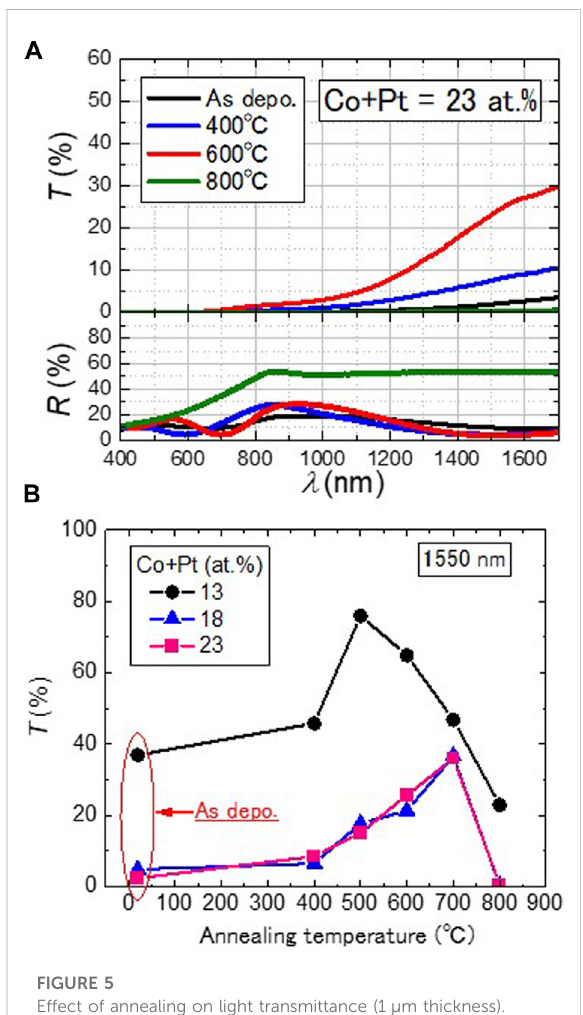
FIGURE 5 Effect of annealing on light transmittance (1 μ m thickness). (A) Wavelength dependence of the transmittance of (Co-Pt)- (CaF 2 ) (Co. + Pt = 13, 18 and 23) nanogranular fi lms at various annealing temperatures. (B) Relationship between transmittance of (Co-Pt)-(CaF 2 ) (Co. + Pt = 13, 18 and 23 at%) nanogranular fi lms at 1,550